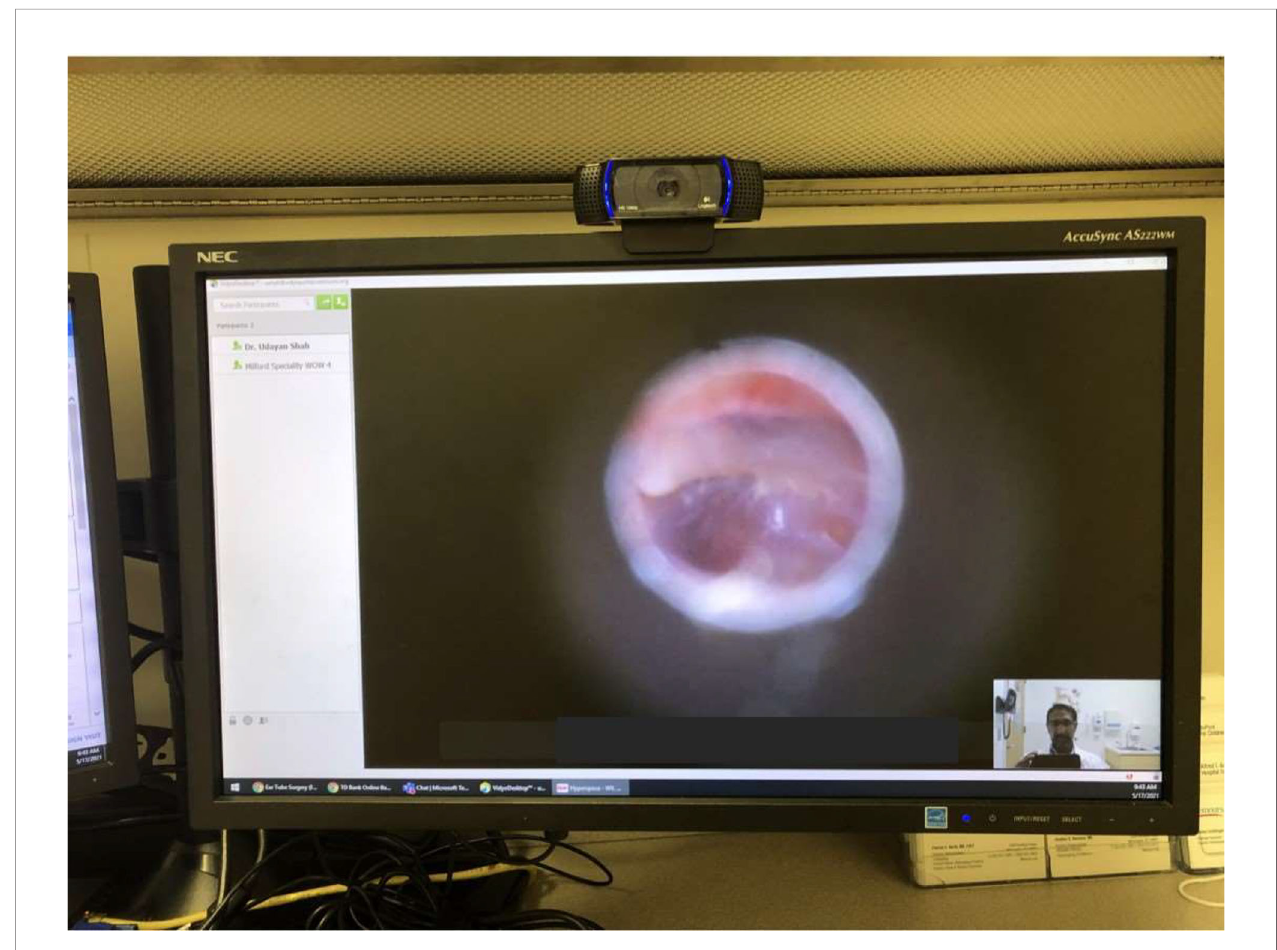
FIGURE 3 | Otoscopy via telemedicine. The camera is at top of the